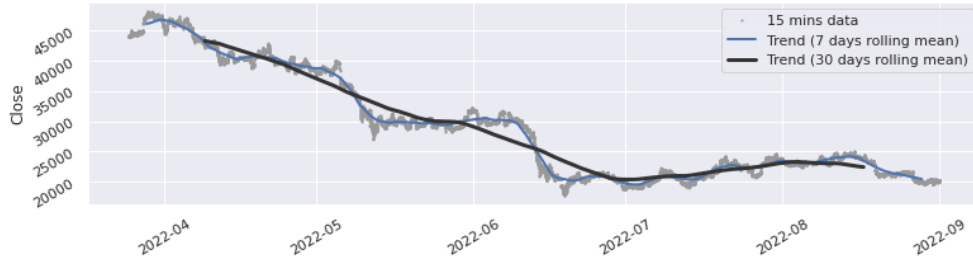
Figure 2. Trend analysis for BTC-USDT closing